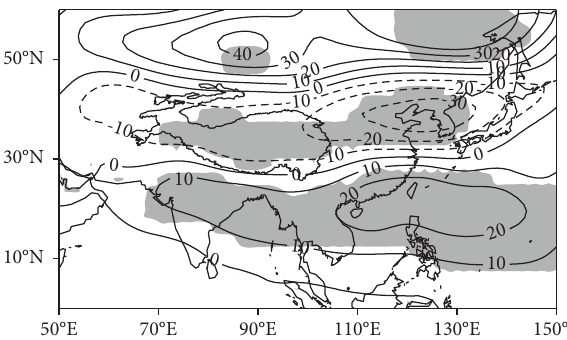
Figure 9: Diference synthetic feld of 500hPa height feld of strong AHS/weak westerly-monsoon year and weak AHS/strong westerly- monsoon year (unit: gpm, shadow indicates passing 95% reliability test).